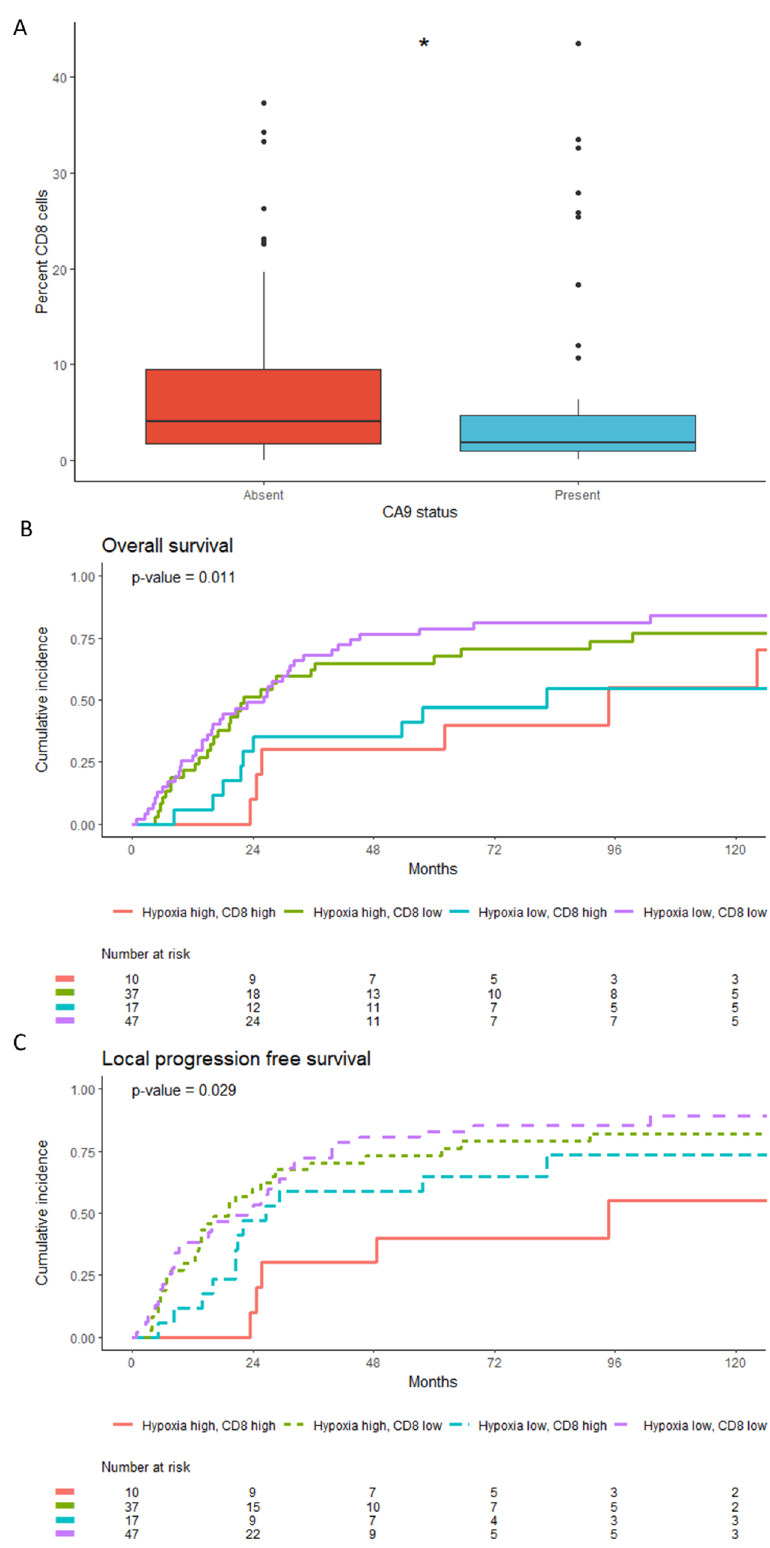
Figure 4. ( A ) Boxplot showing the population density for CD8 when grouped into CA9 absent or present. p values < 0.05 are represented by *. ( B ) Cumulative incidence of events for overall survival and ( C ) local progression free survival according to percent CD8 low/high, hypoxia low/high. Tumours were stratified into hypoxia low or high using the CA9 IHC status and CD8 high or low using the upper quartile as done previously. p values are calculated using the “cmprsk” package in R.